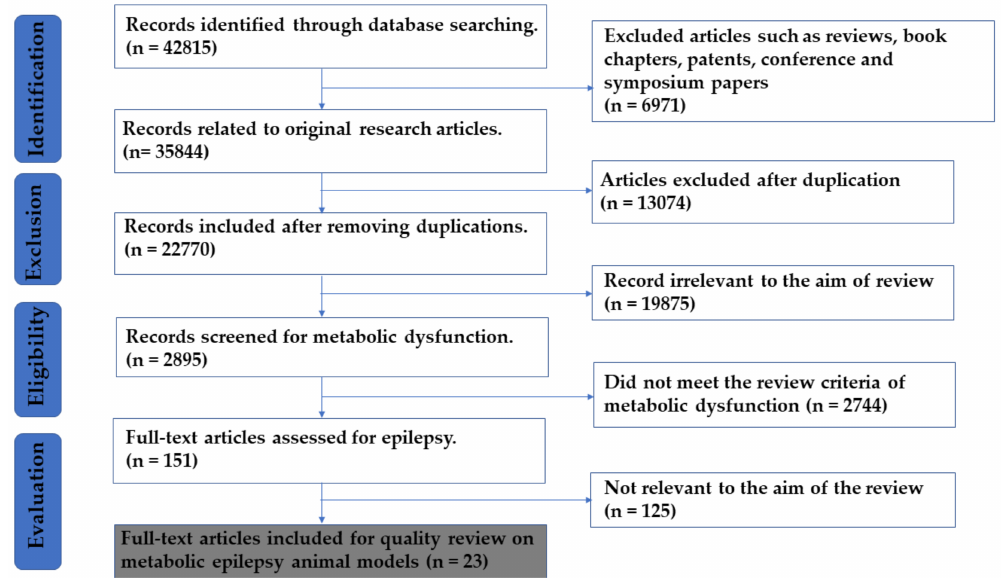
Figure 3. Study evaluation PRISMA flow chart for selection of